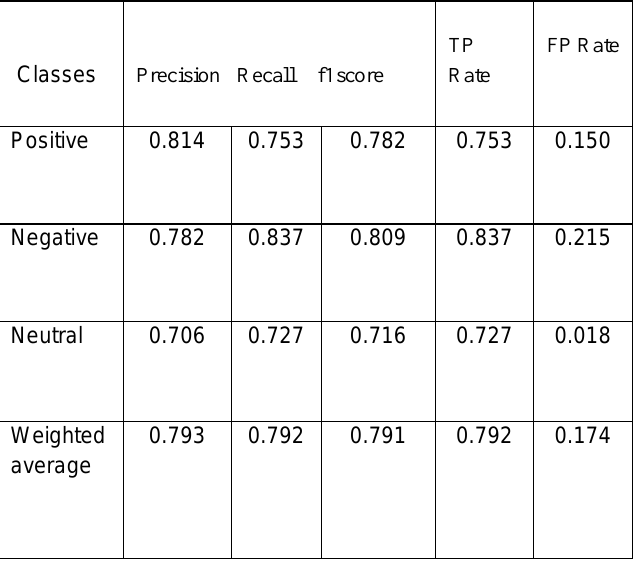
Table 4. Proposed Naïve Bayes Classification with BOW